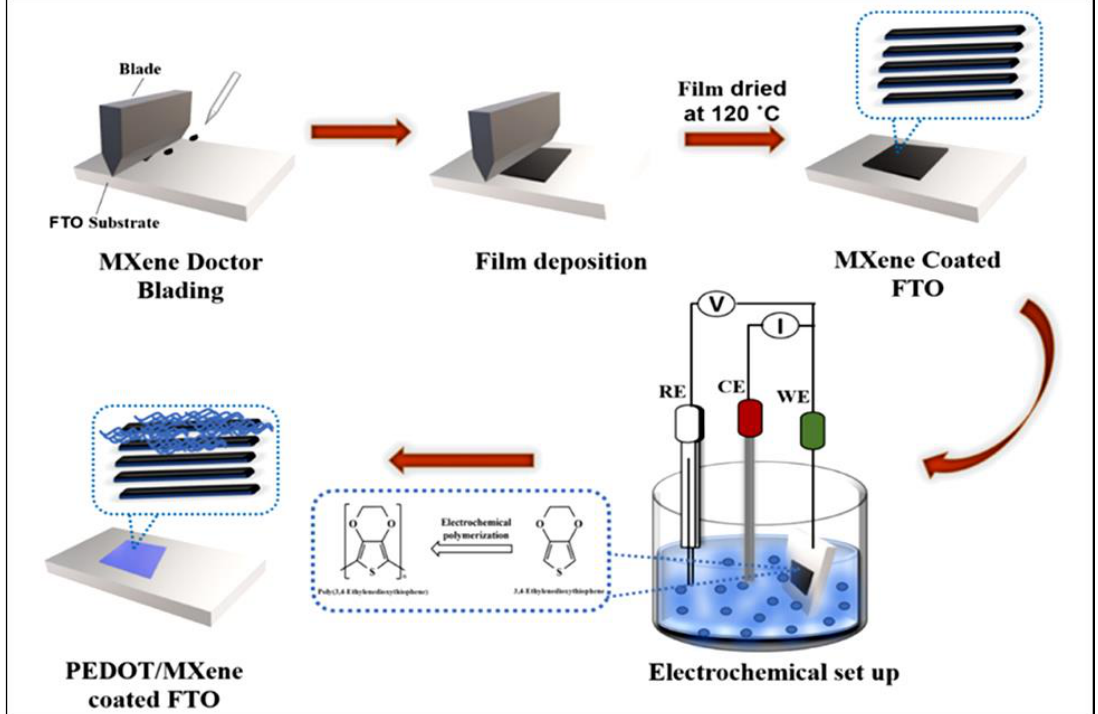
Figure 6. A schematic illustration of a PEDOT-MXene-based DSSC. The images have been reproduced with permission [112] .